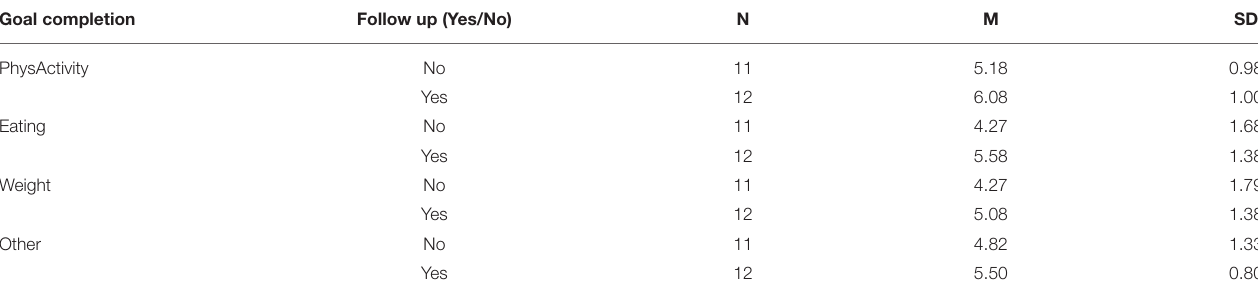
TABLE 4 | Means (M) and Standard deviations (SD) comparing participants who participated in the follow-up with participants who did not. Goal completion